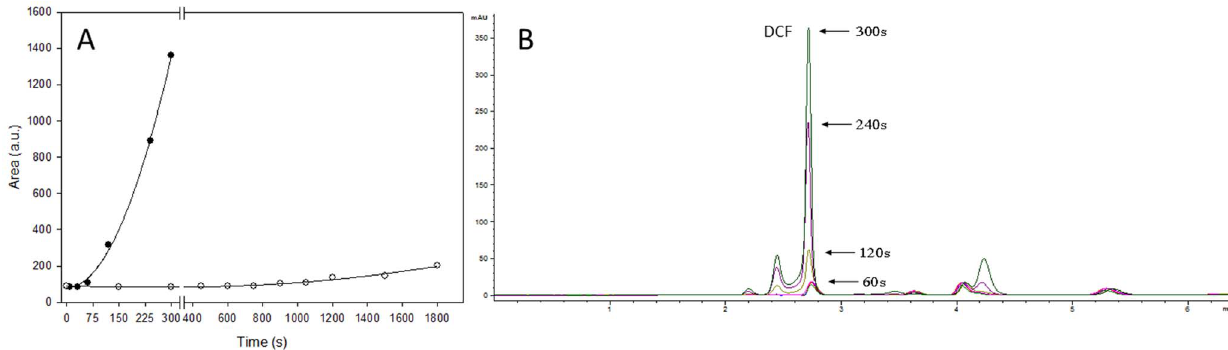
N Figure 2. Time-dependence in melatonin effect on DCFH 2 photooxidation. A) Time course of DCF production by DCFH 2 (10 m M) alone (- # -) -) under light. B) Chromatogram of DCF after DCFH 2 (10 m M) plus MEL (1 mM) were exposed to light for 60, 120, 240 or or plus MEL 1 mM (- 300 seconds.